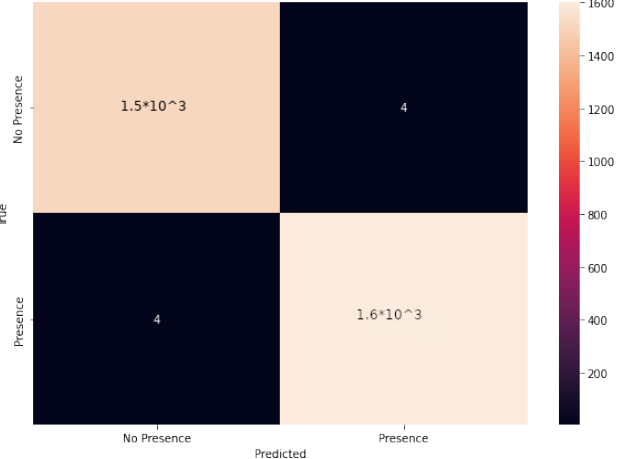
Figure 9. The confusion matrix relevant to the presented